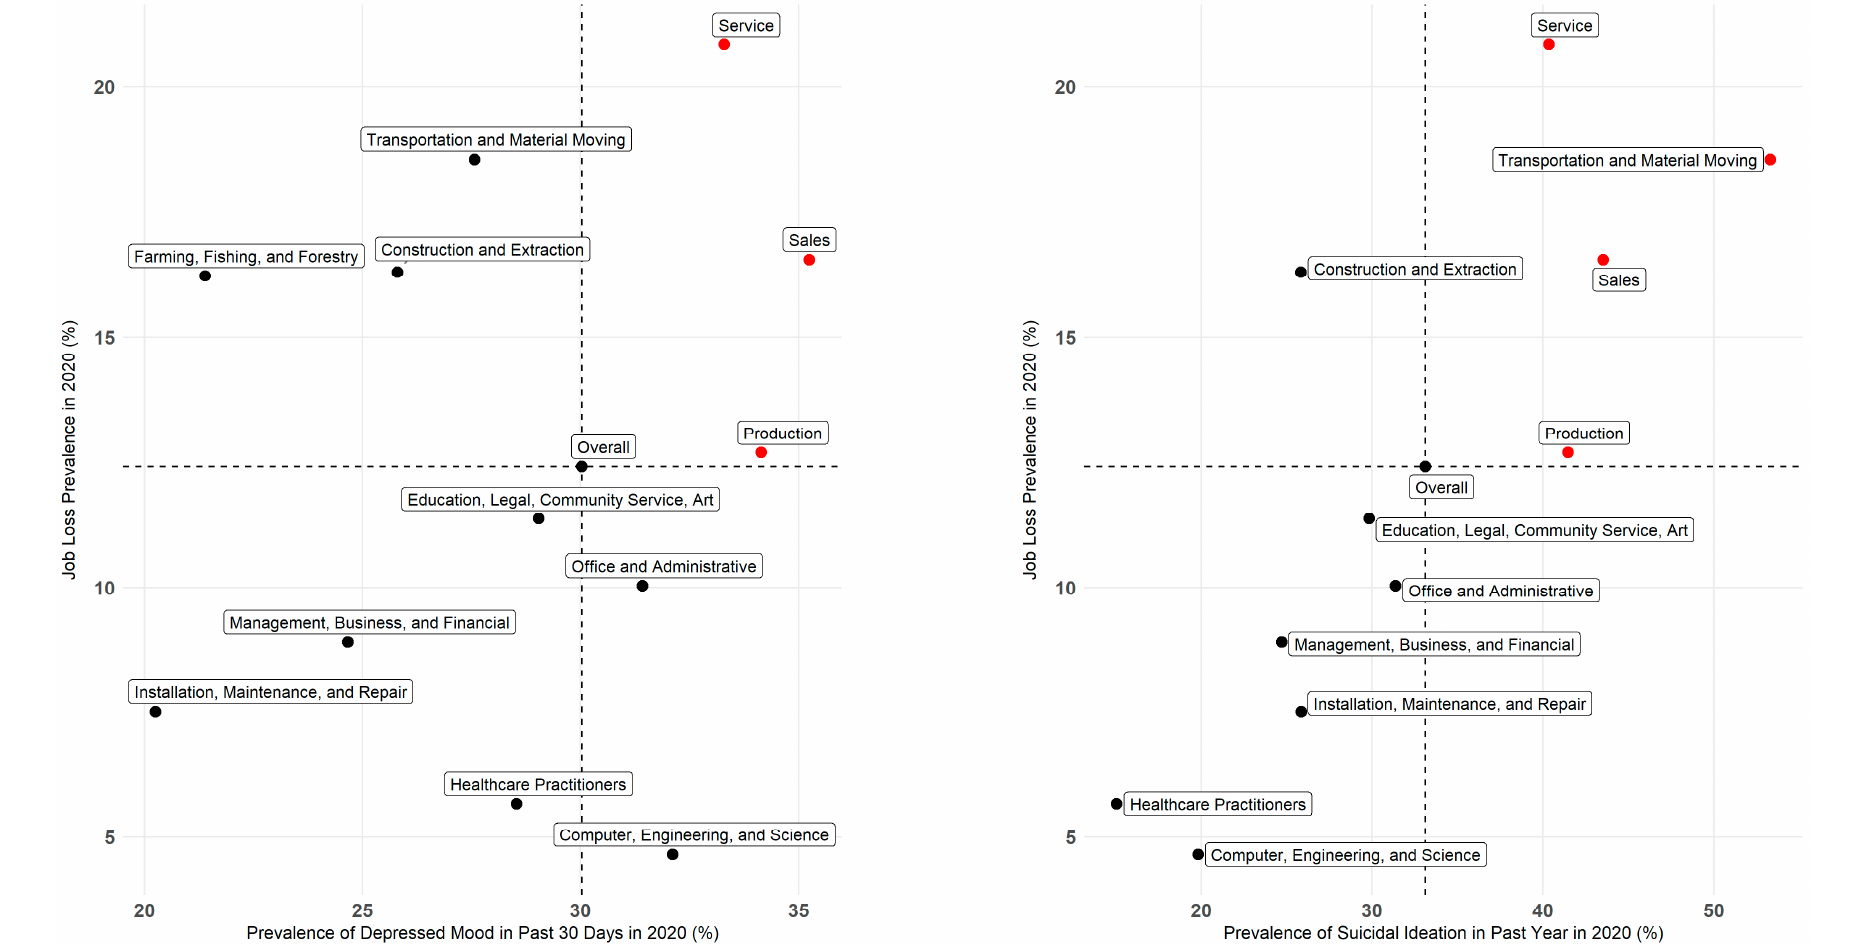
Figure 2. Prevalence in 2020 of job loss and depressed mood among California workers, and prevalence in 2020 of suicidal ideation in the past year among California workers who had ever thought of suicide.